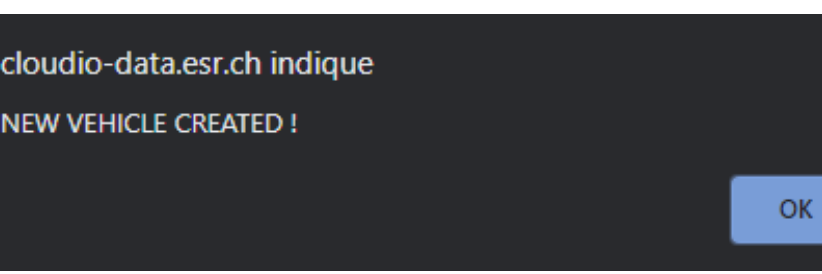
Figure 16. A confirmation message provided upon the registration of a new